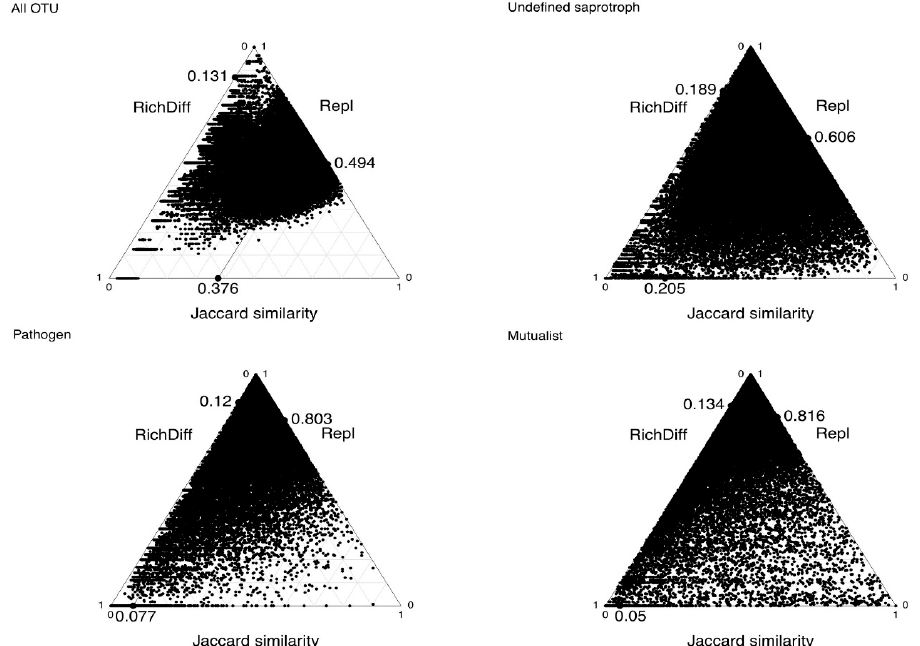
Figure 5. Triangular plots (simplex) of the beta diversity partition for all OTU and three functional guilds. RichDiff = richness difference; Repl = species replacement. The bold numbers are median values.